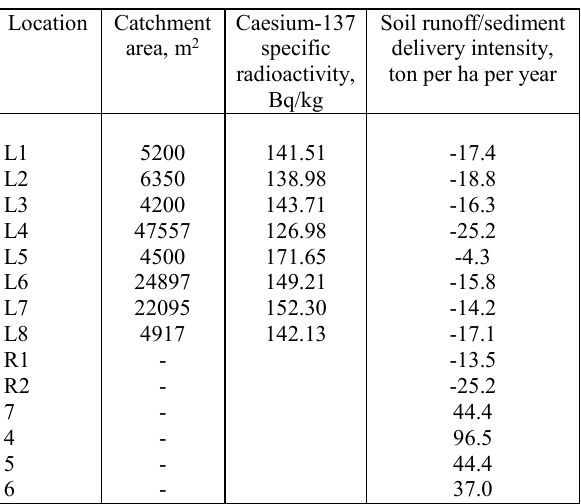
Table 1 . Soil runoff from the slopes, and delivery of sediments to the main